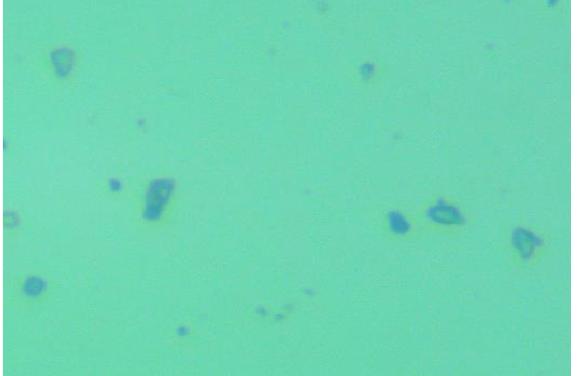
Fig. 2. Micrographs of metronidazole benzoate